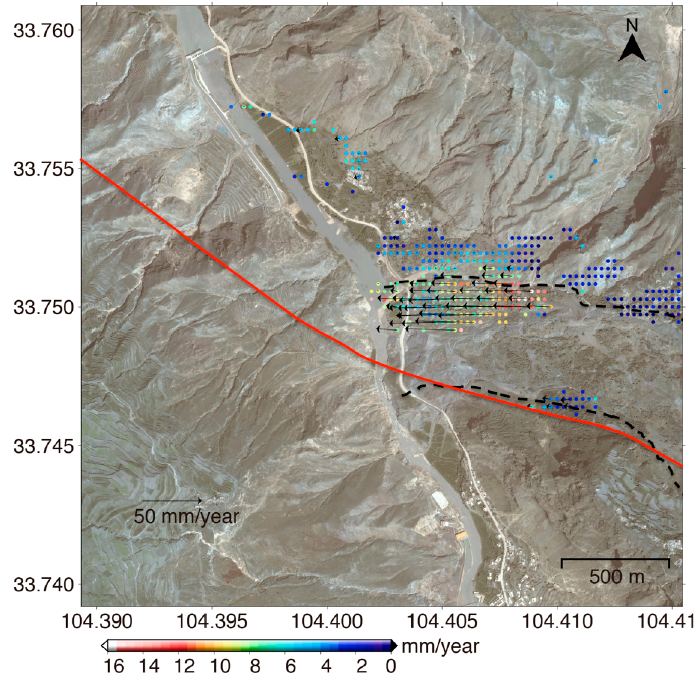
Figure 10. 3D deformation rates of the Xieliupo landslide, where the color and the arrow represent the vertical and horizontal deformation velocities, respectively. Black dashed line outlines the scope of the Xieliupo landslide [38]. Red line marks the location of Pingding-Huama fault [38].